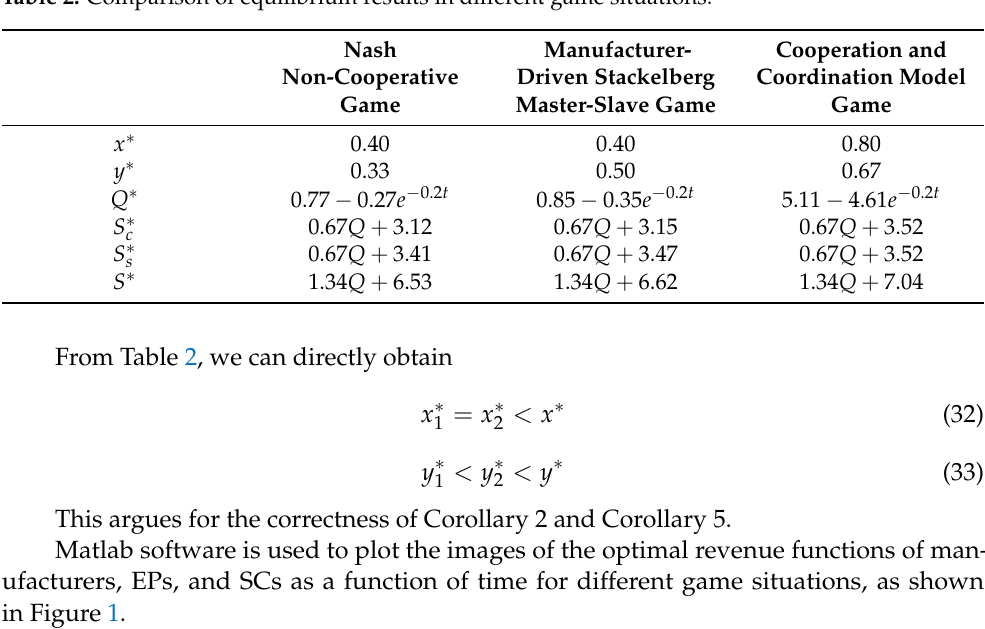
Table 2. Comparison of equilibrium results in different game situations.